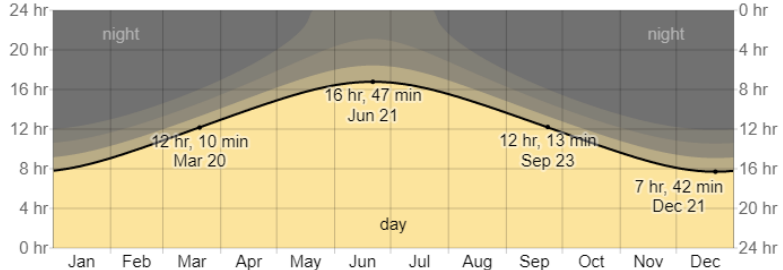
Figure 17. Hours of daylight and twilight in Warsaw, Poland [76].